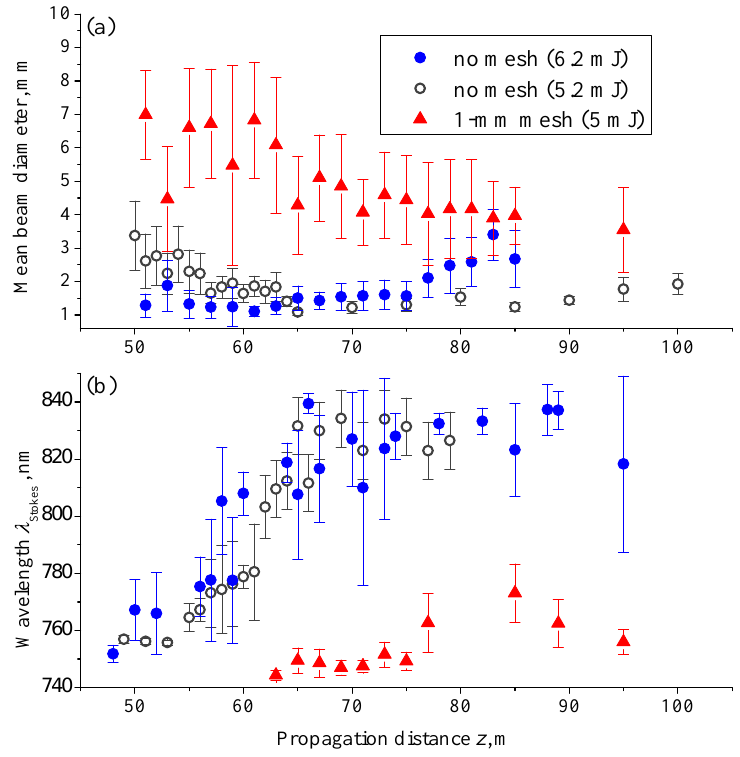
Figure 6. Dependencies of ( a ) the beam diameter and ( b ) the position λ Stokes of the longest- wavelength maximum in the spectrum on the propagation distance z . Filled blue circles and open gray circles stand for the free beams with the pulse energies of 6.2 and 5.2 mJ, respectively. Red triangles represent data in the case of beam regularization by the 1 mm